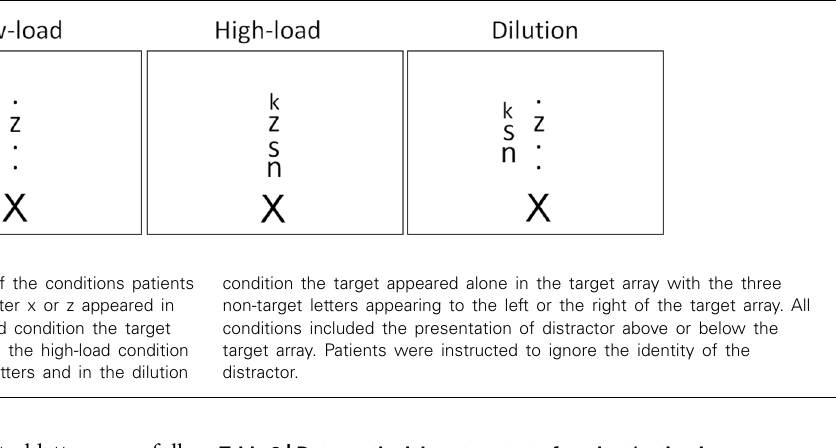
Table 2 | Data on the laboratory test of